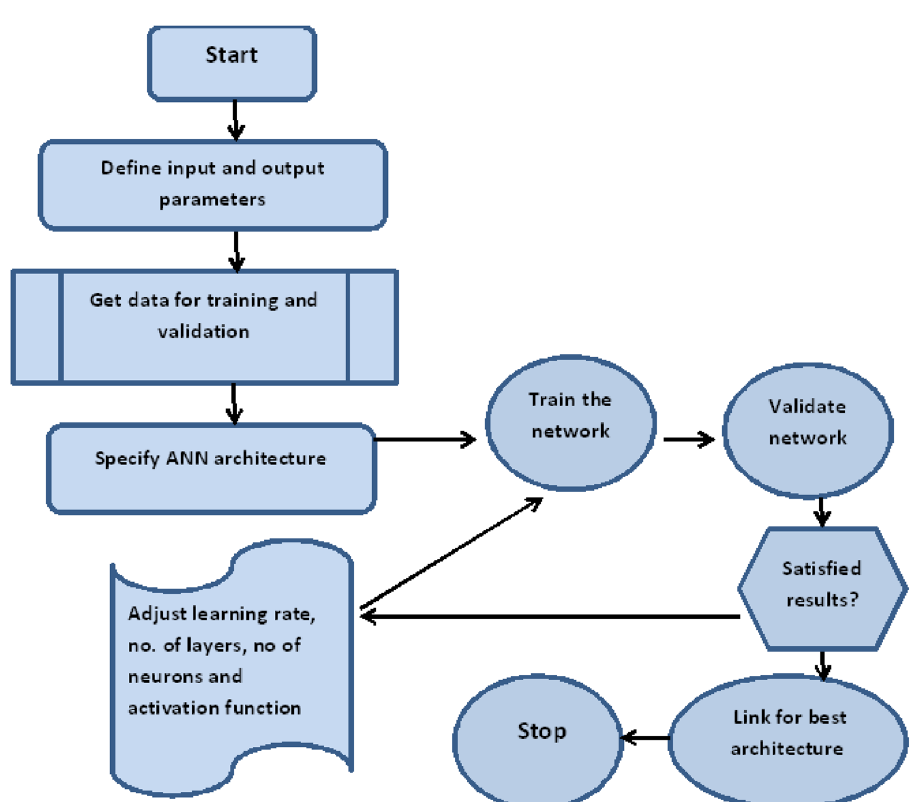
Figure 18. ANN training and development flow